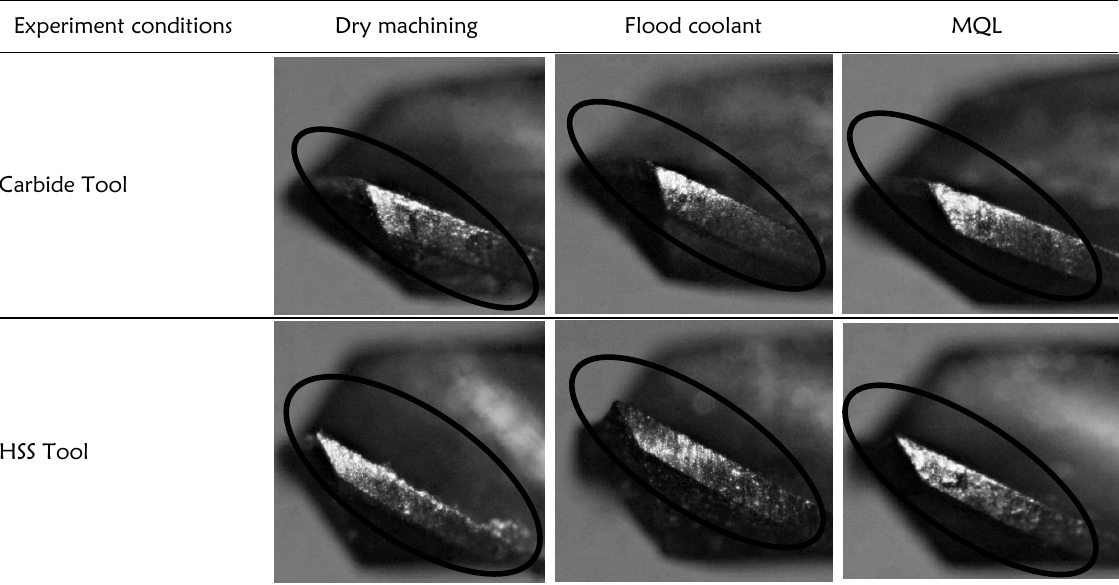
Table 5: Flute condition for Carbide and HSS tools